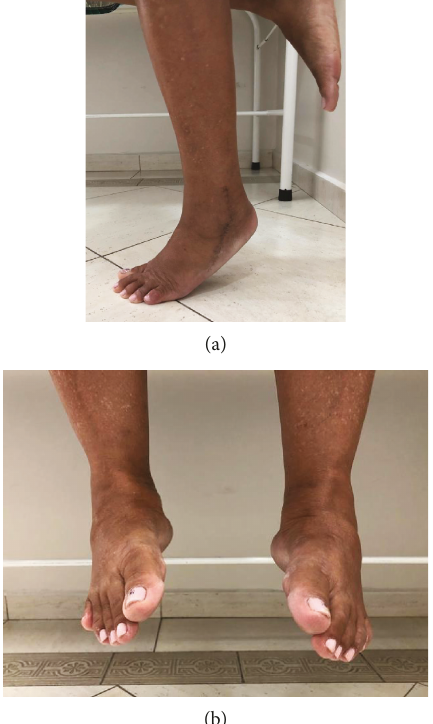
Figure 9: Patient II: (a) single-heel rise test and (b) inversion range of motion at 6 months after